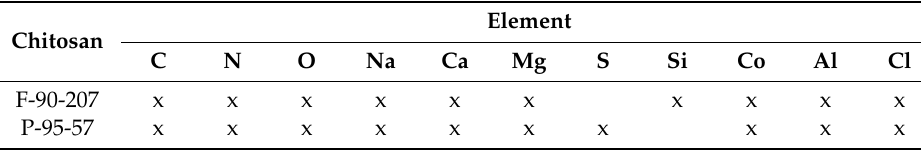
Table 2. Elemental analysis via EDS-SEM in chitosan